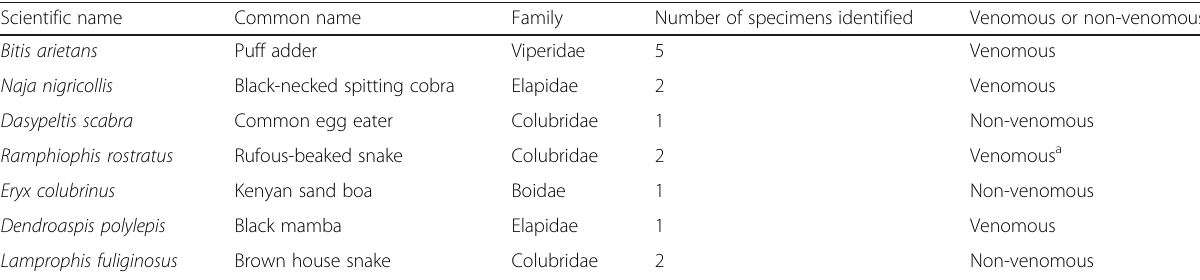
Table 1 List of snake species recorded in Meserani Juu village (Monduli district) and Lesiraa village (Arumeru district) in the Arusha region. The list is based on dead snakes collected in field and identified by a